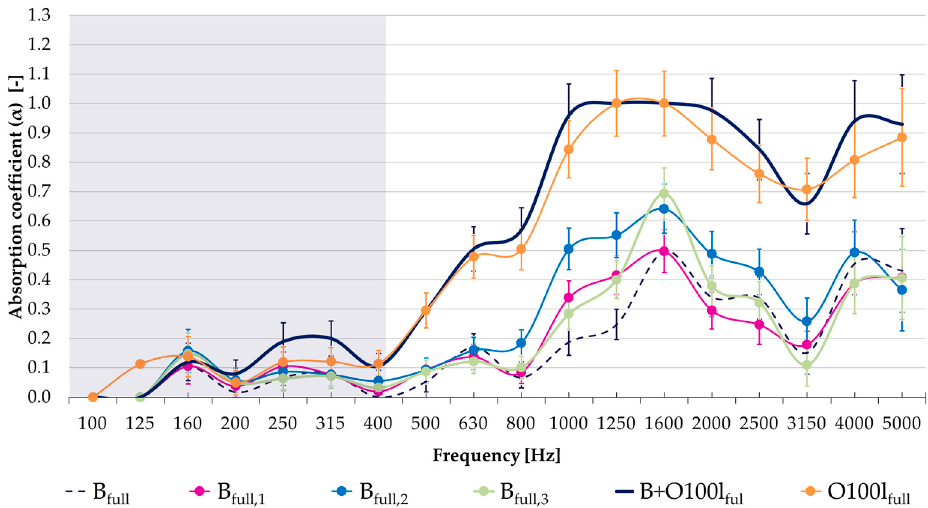
Figure 12. The obtained random incidence sound absorption coefficients of the B full , B full,1 , B full,2 , B full,3 , B+O100l full , and O100l full configurations, together with the standard deviations of the results of each sample configuration.